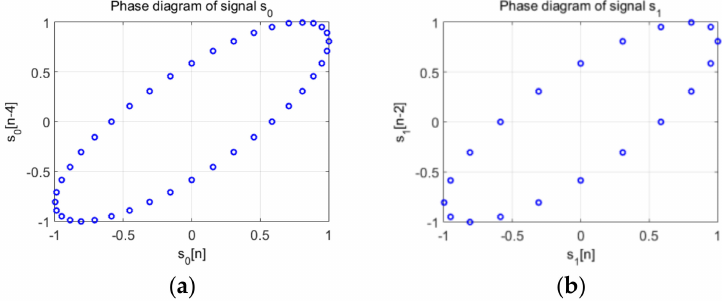
Figure 11. ( a ) The phase space trajectory of the signal s 0 from Equation (19) where d = 4 and m = 2; ( b ) The phase space trajectory of the signal s 1 from Equation (19) d = 2 and m =